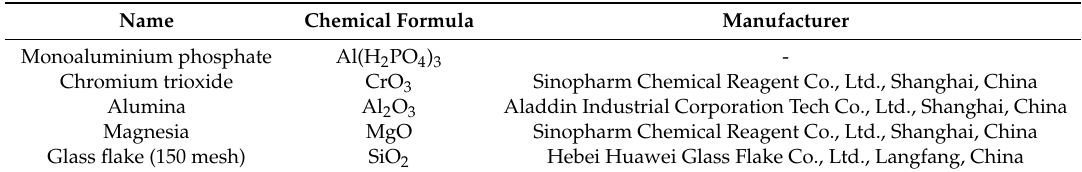
Table 1. Raw material of phosphate ceramic